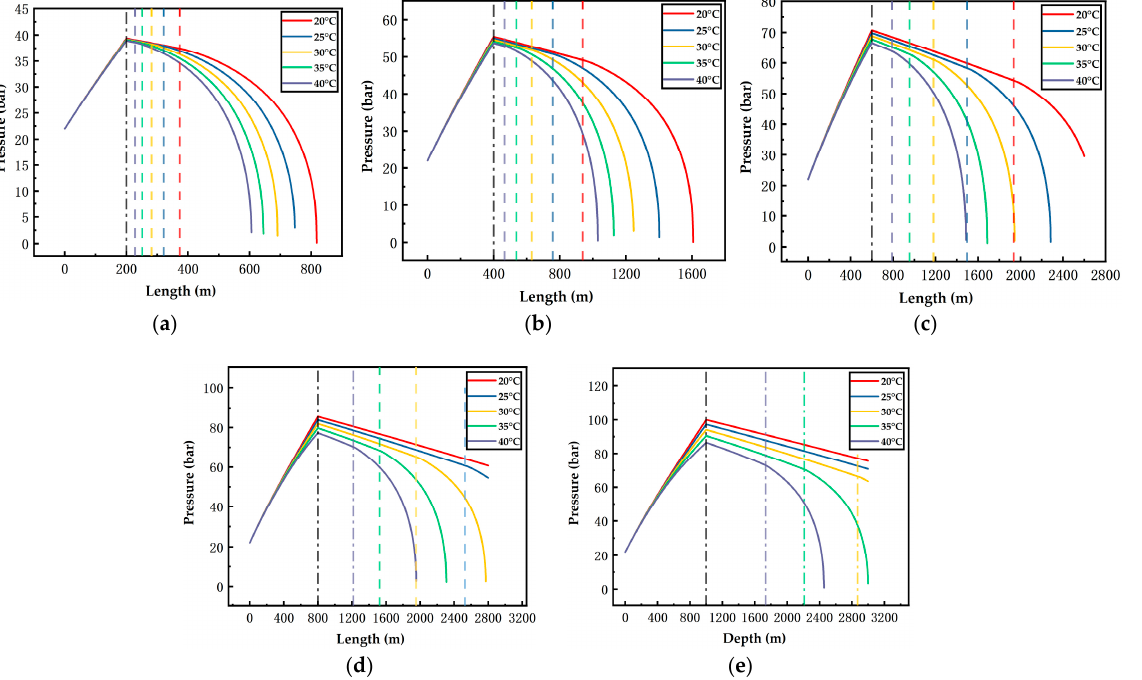
Figure 11. Variation of the on-way pressure with the length at 15 m/s airflow velocity, different ambient temperatures and depths (( a ) 200 m; ( b ) 400 m; ( c ) 600 m; ( d ) 800 m; ( e ) 1000 m). The black dotted line indicates the connection between the vertical pipe and the underground pipe; The dotted lines in other colors indicate gasification points.